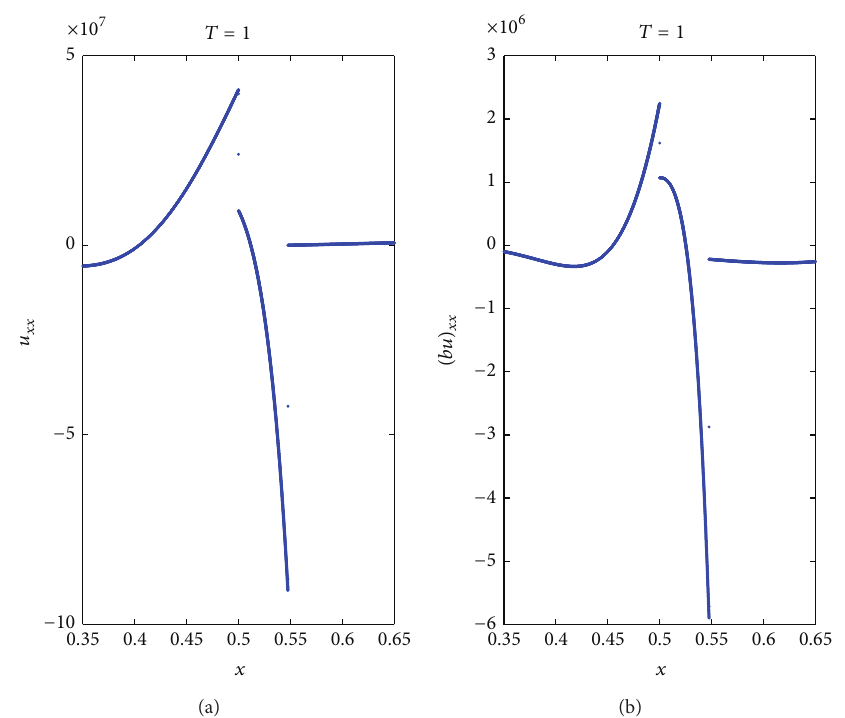
Figure 3: Test Problem 3. Approximated second derivative of 𝑢 (a) and approximated second derivative of 𝑏𝑢 (b).